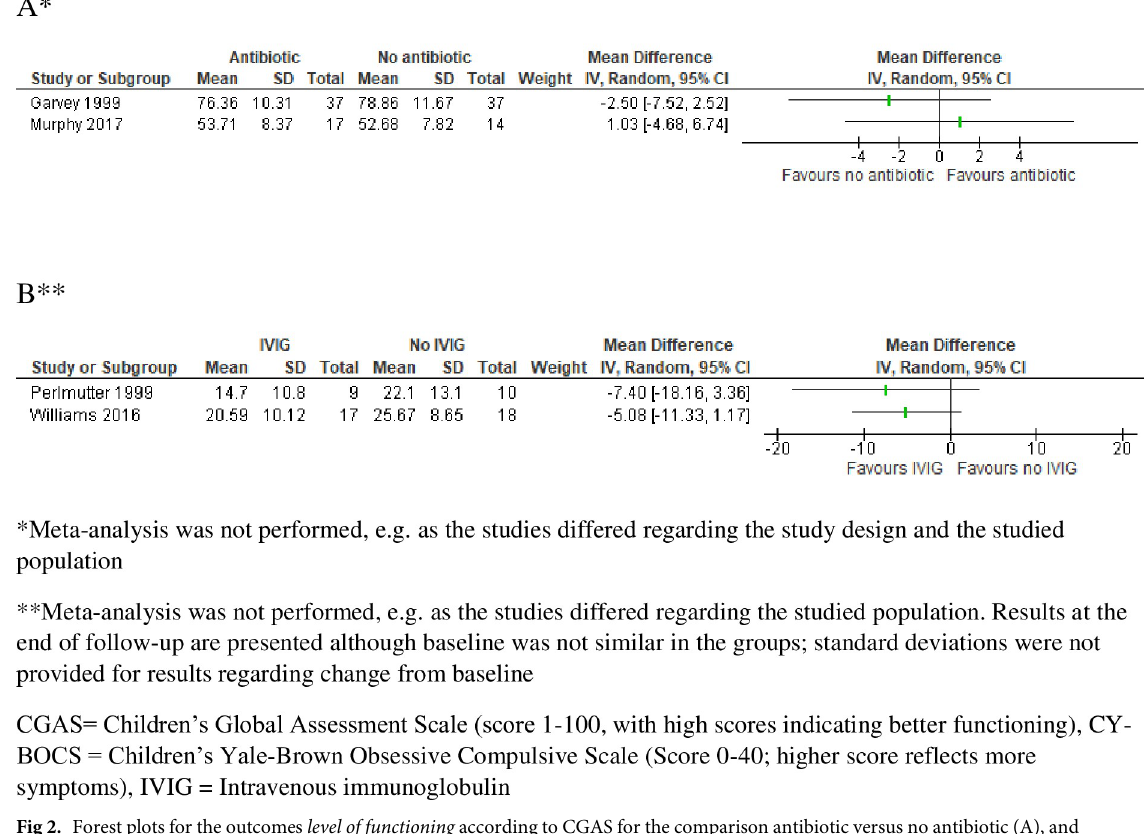
Fig 2. Forest plots for the outcomes level of functioning according to CGAS for the comparison antibiotic versus no antibiotic (A), and symptoms according to CY-BOCS for the comparisons IVIG versus no IVIG (B). Due to clinical and methodological diversity, in the absence of an established diagnosis and with major risk of bias in all studies (e.g. selection and detection bias), we refrained from pooling the results.